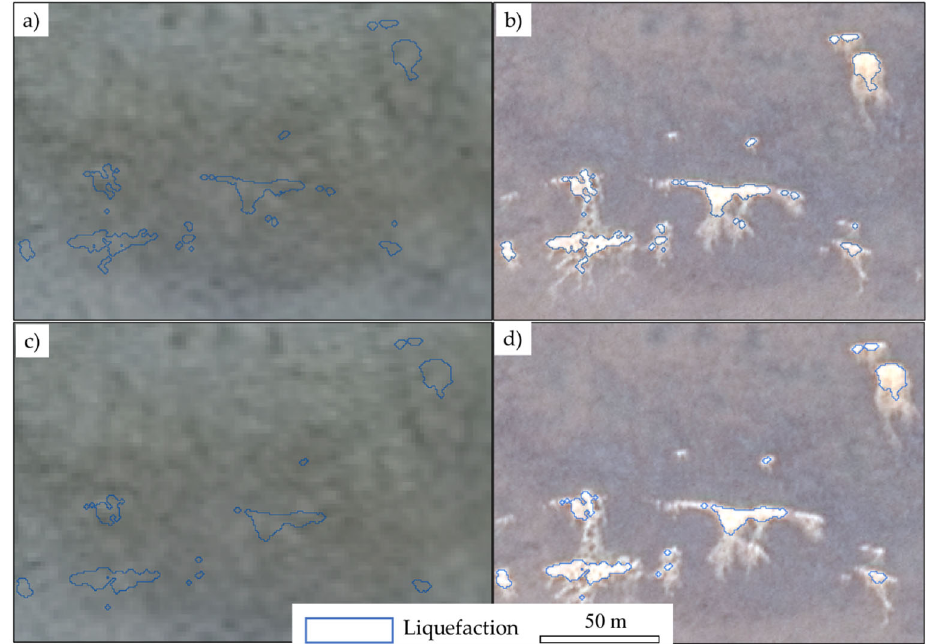
Figure 7. The extracted liquefaction (region Ⅰ ) by the two proposed methods. ( a ) GF-1D image pre- earthquake with liquefaction extracted by RF. ( b ) GF-7 image post-earthquake with the liquefac- tion predicted by RF. ( c ) UAV image post-earthquake with liquefaction predicted by RF. ( d ) GF- 1D image pre-earthquake with liquefaction predicted by GBDT. ( e ) GF-7 image post-earthquake with liquefaction predicted by GBDT. ( f ) UAV image post-earthquake with liquefaction predicted by GBDT.